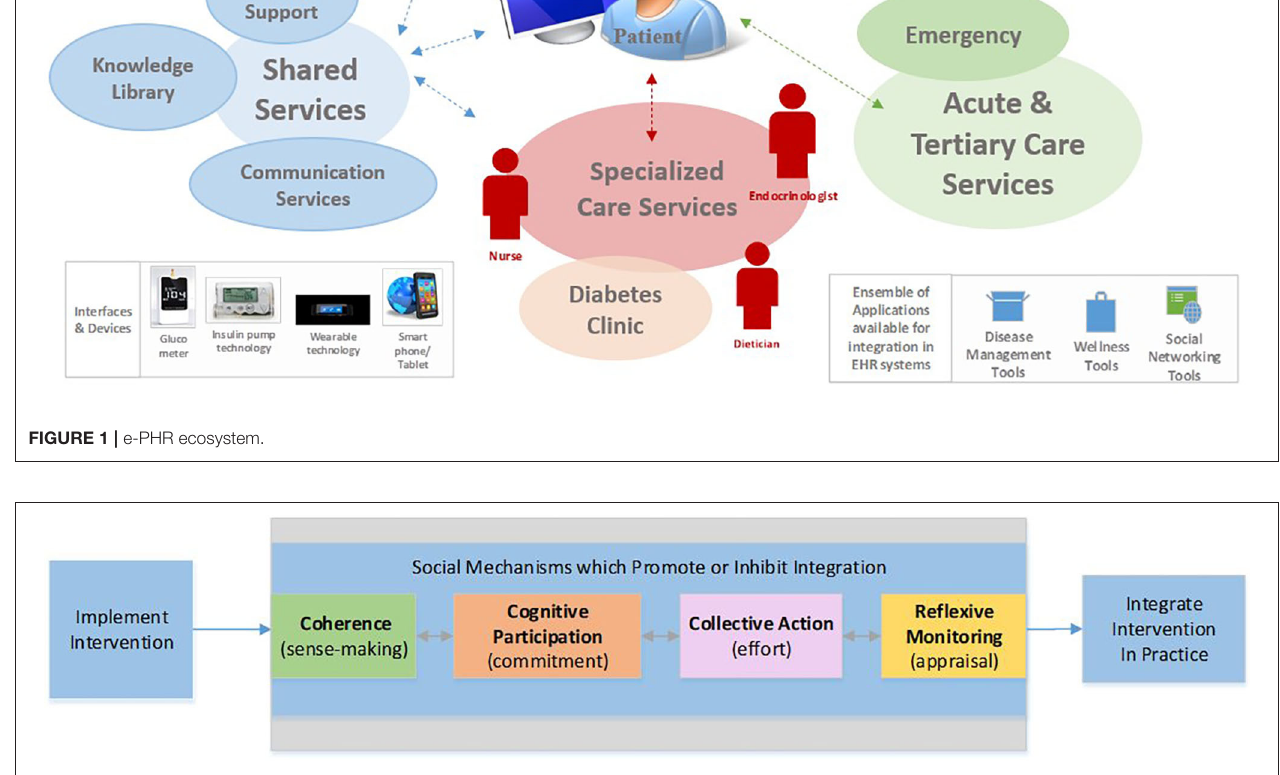
FIGURE 2 | Normalization Process Theory